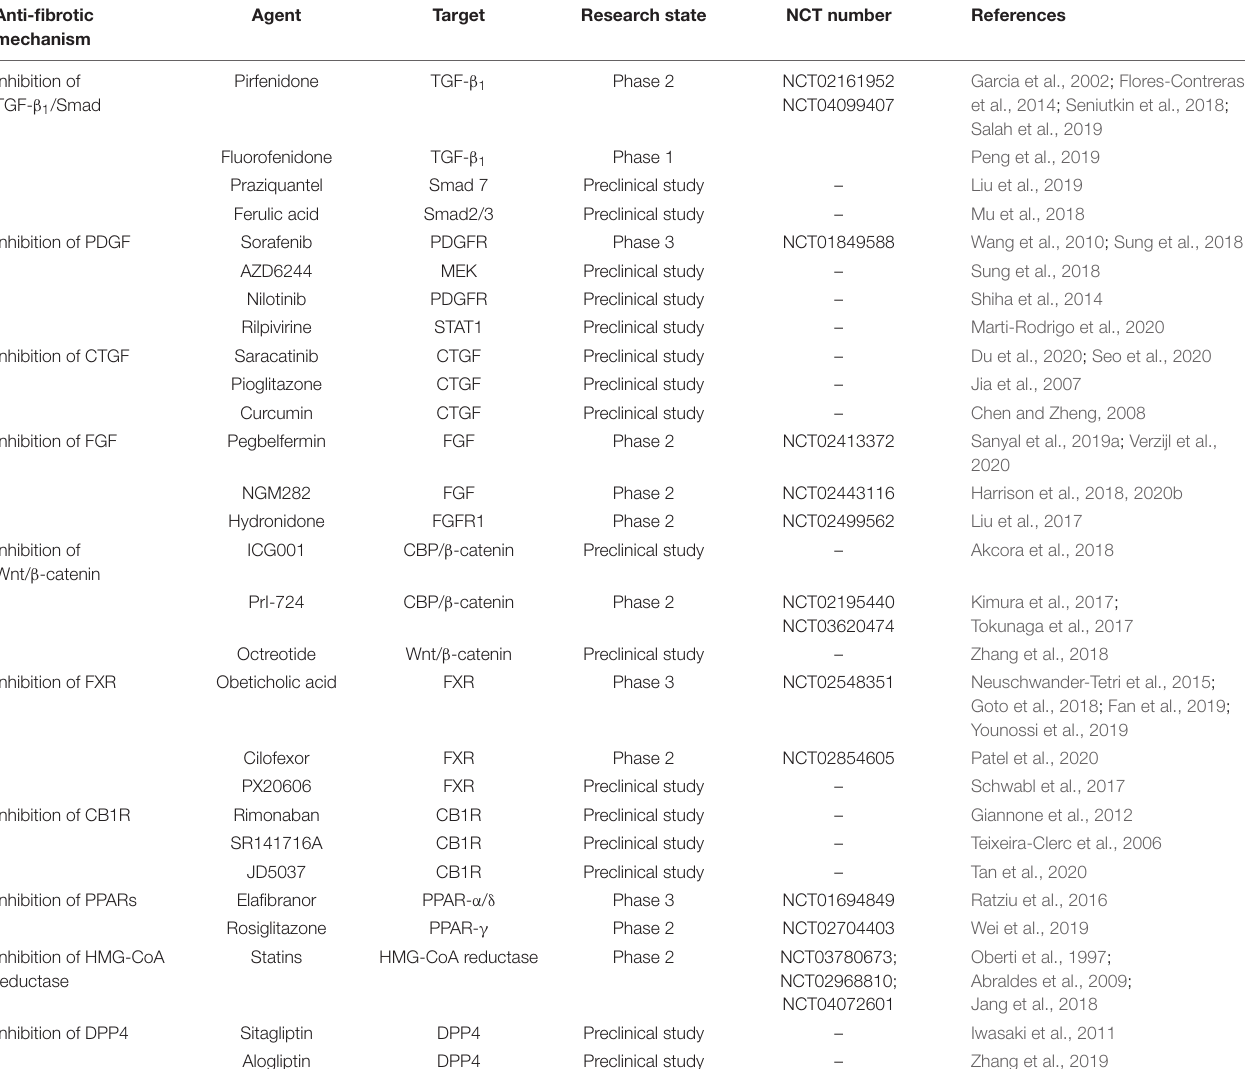
TABLE 2 | Anti-hepatic fibrosis drugs related to inhibiting HSCs activation and